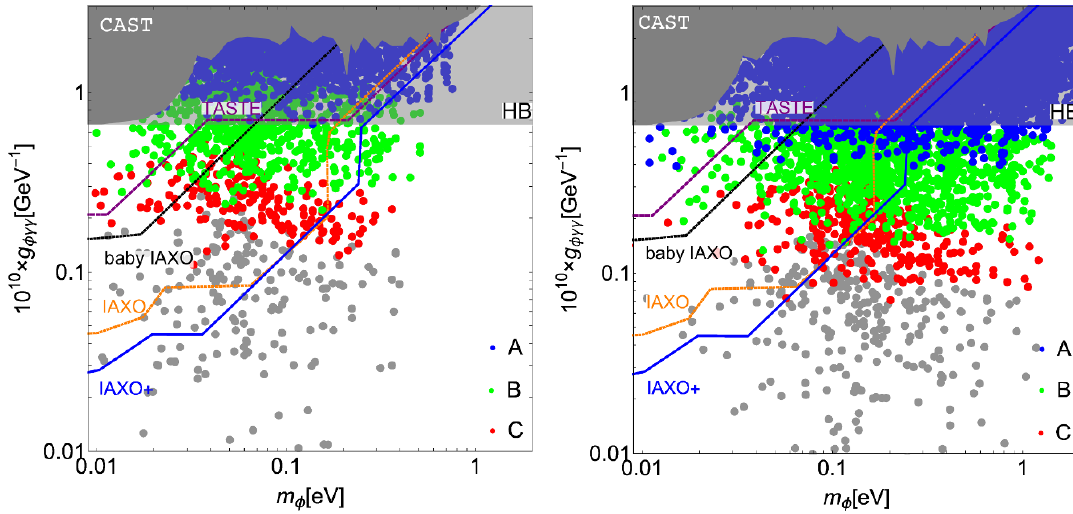
Figure 4 . Scatter plot of the viable parameters consistent with the CMB observation and the dark matter abundance for C = 10 (left panel) and C = 30 (right panel). The colors of the points correspond to the ratio of the ALP couplings to photons and hypercharge gauge bosons (see the text). The constraints, as well as the projected sensitivity reaches, are same as in (cid:12)gure 3.